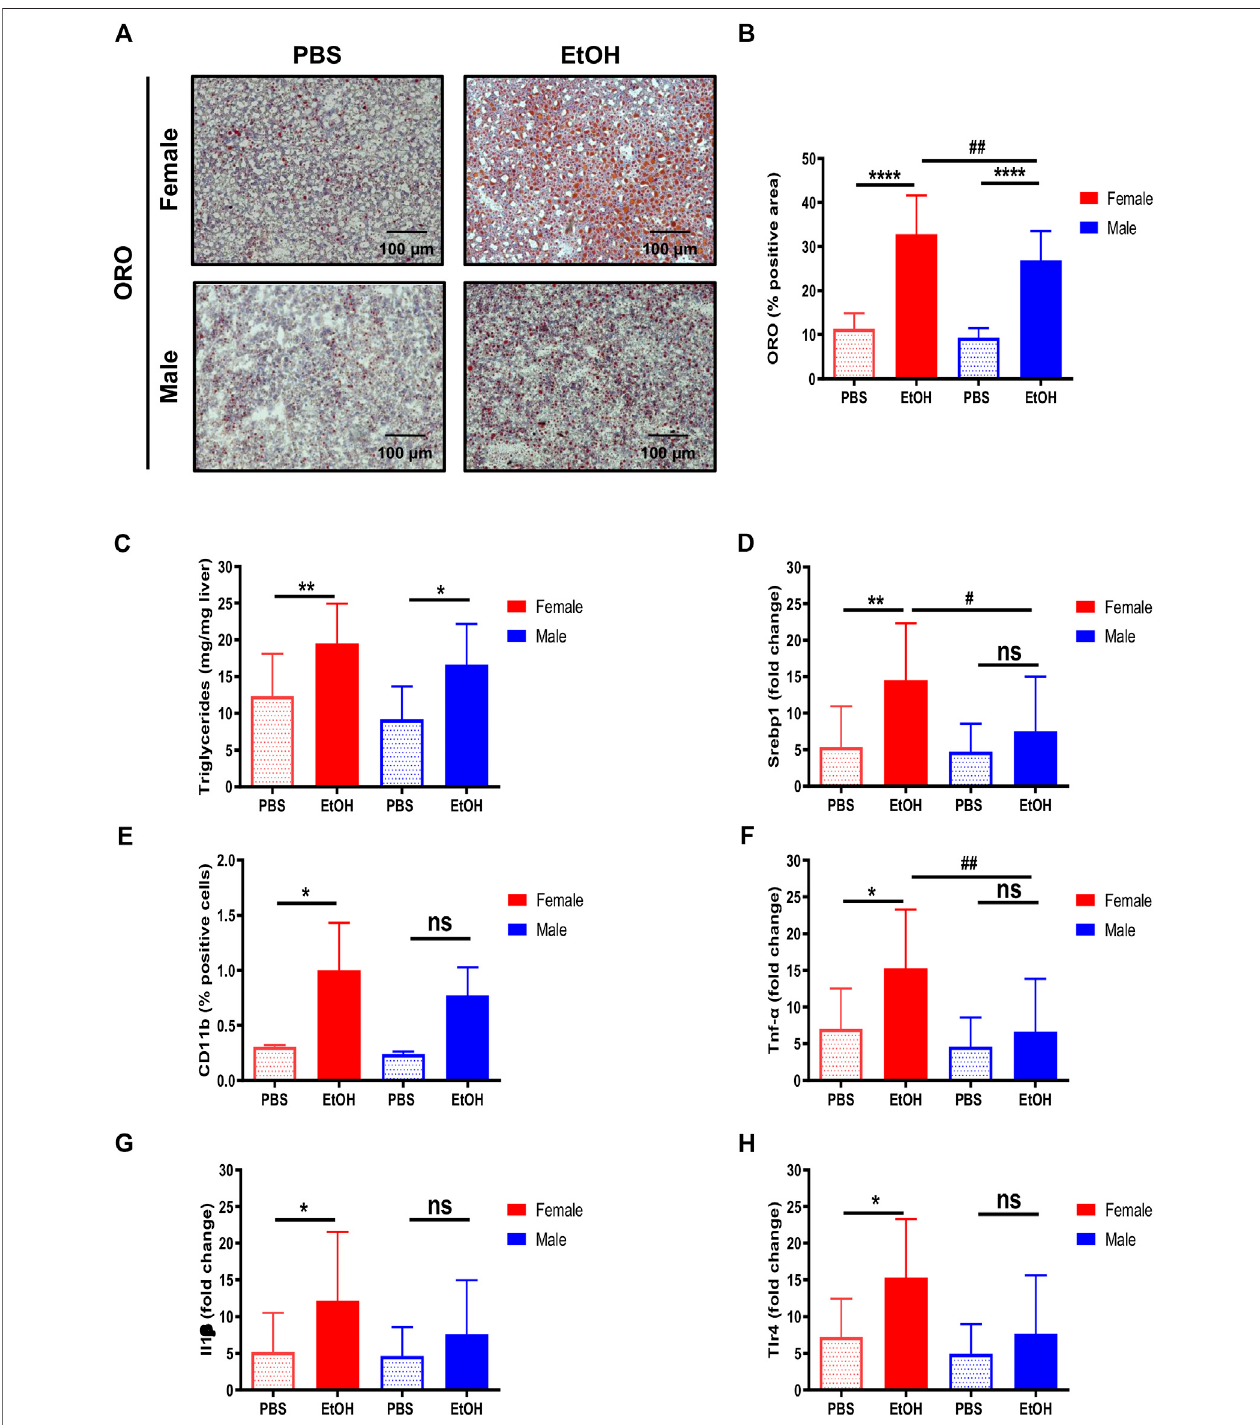
FIGURE 3 | Hepatic lipid accumulation and in fl ammation are characteristic of female mice. (A) ORO staining performed in liver cryosection of female and male C57BL/6JmicetreatedwithEtOH[6 g/kg]orPBS. (B) Quanti fi cation oflipiddroplets byOROpositiveareawasdoneand graphed( n (cid:1) 5 – 6/group). (C) Quanti fi cationof hepatictriglycerideswasdoneandgraphed( n (cid:1) 8/group). (D) Srbp-1 mRNAexpressionwasdeterminedbyqPCRandnormalizedtotheamountofGAPDHintheliverof female and male mice ( n (cid:1) 5 – 8/group). (E) Quanti fi cation of CD11b positive cells was done and graphed ( n (cid:1) 3/group). (F) Tnf- α , (G) Il1 β , and (H) Tlr4 mRNA expression determined by qPCR and normalized to the amount of gapdh in liver of female and male mice ( n (cid:1) 4 – 10/group; * p < 0.05, **** p < 0.0001, # p < 0.05, ## p < 0.01).